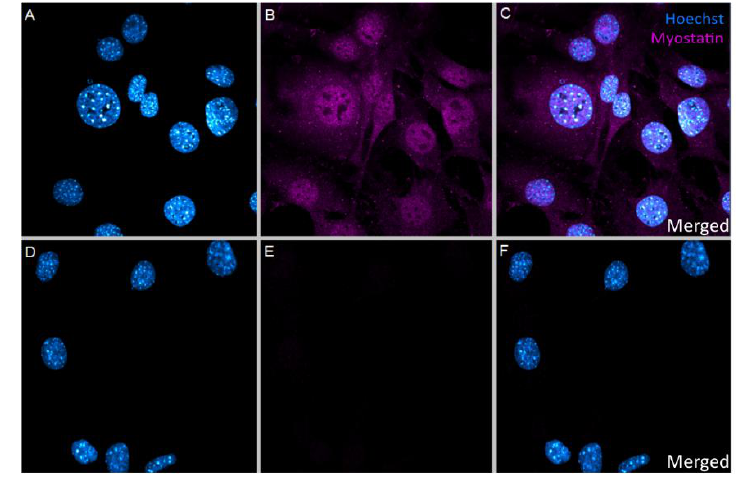
Figure 1. A – F : Immunocytochemical staining of VSMCs. A – C – VSMCs treated with 10 nM myostatin Figure 1. ( A – F ): Immunocytochemical staining of VSMCs. ( A – C )—VSMCs treated with 10 nM showed uptake of myostatin in the cell, concentrating mostly in the nucleus. A —Hoechst only, B — myostatin showed uptake of myostatin in the cell, concentrating mostly in the nucleus. ( A )—Hoechst Myostatin only, C —Merged image. D – F —VSMCs not treated with myostatin showed no endogenous only, ( B )—Myostatin only, ( C )—Merged image. ( D – F )—VSMCs not treated with myostatin showed no myostatin presence in the cells at all. D —Hoechst only, E —Myostatin only, F —Merged image. Picture endogenous myostatin presence in the cells at all. ( D )—Hoechst only, ( E )—Myostatin only, ( F )—Merged taken with 63× magnification. image. Picture taken with 63 ×